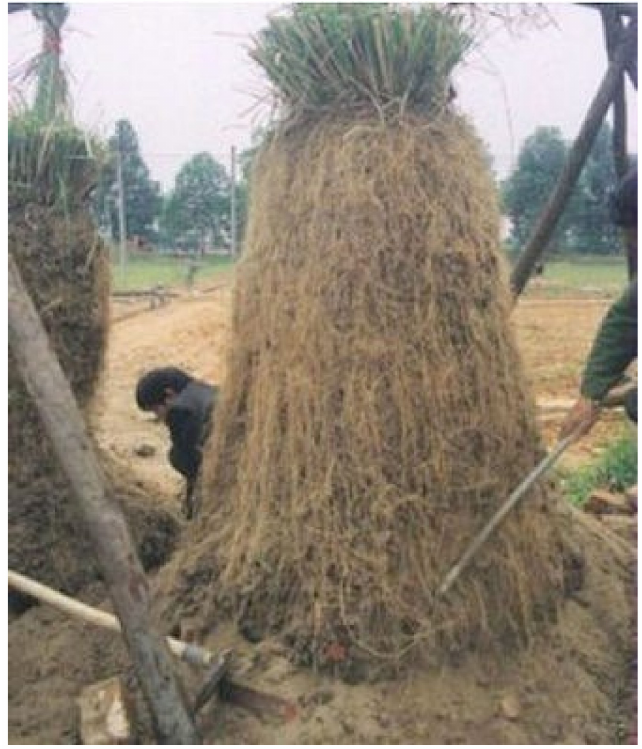
Figure 1. Vetiver with extensive roots for anchoring soil